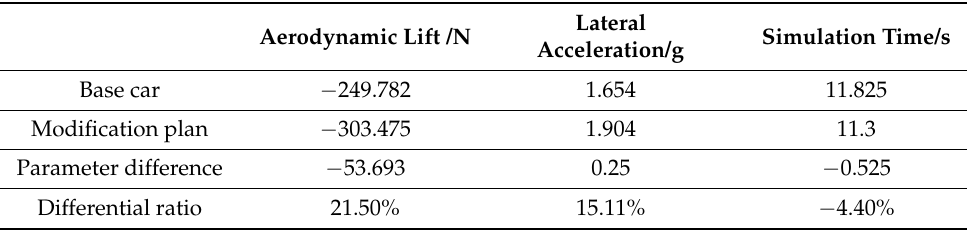
Table 11. Comparison of performance parameters of figure-eight surround simulation before and after adjusting aerodynamic parameters under pitching